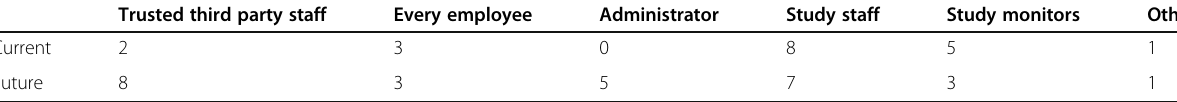
Table 3 Response to the question: “ Who has access to the patient consents? ” Trusted third party staff